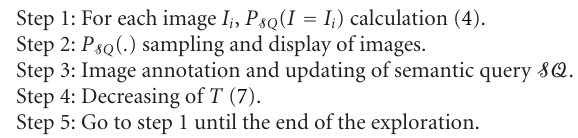
Algorithm 1: Stochastic exploration of the